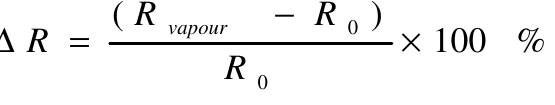
Figure 3. Variation of the current flowing through a fresh TiO changes in the concentration of benzene at room